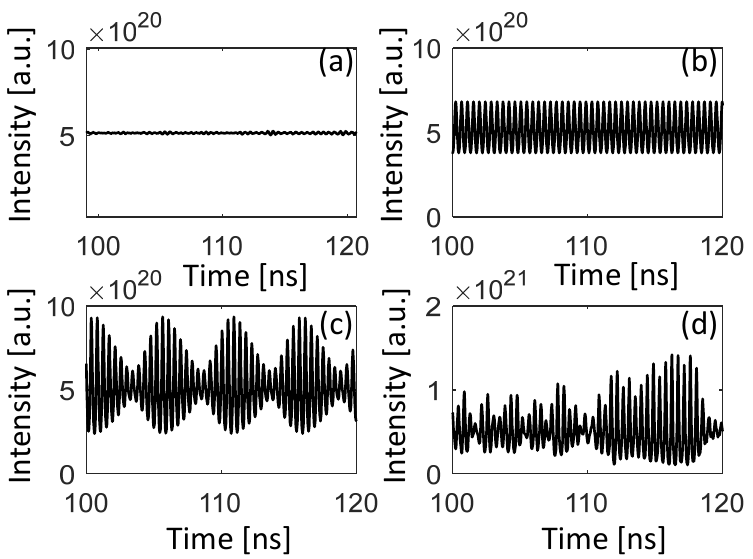
Figure 3. Simulated results for different dynamics of lasers with external optical feedback, ( a ) steady state, ( b ) period-one oscillation, ( c ) quasi-periodic oscillation, ( d ) chaotic oscillation.